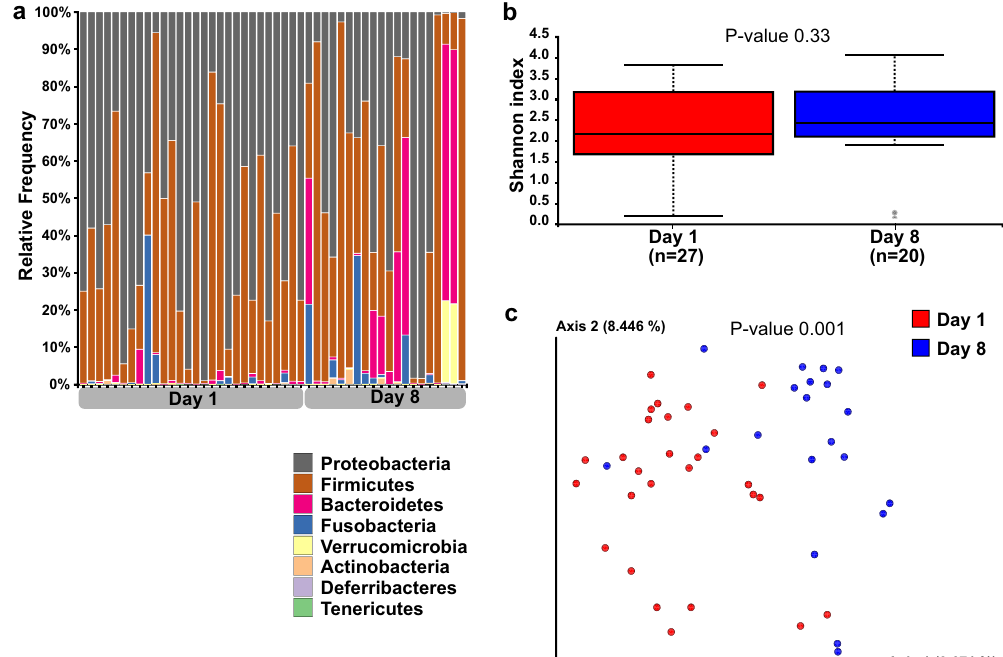
Fig. 1 Rectal bacterial composition in healthy neonatal puppies on Days 1 and 8 post-partum. a Taxonomy bar plot; b alpha diversity analysis using Shannon index; c principal coordinate analysis plot representing beta diversity based on Jaccard distances (permutational multivariate analysis of variance, P =